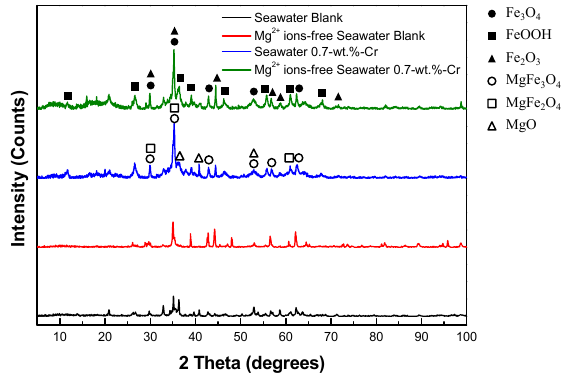
Figure 9. XRD spectra for the top-view products of specimens after 30 days immersion according to seawater conditions and alloying elements.